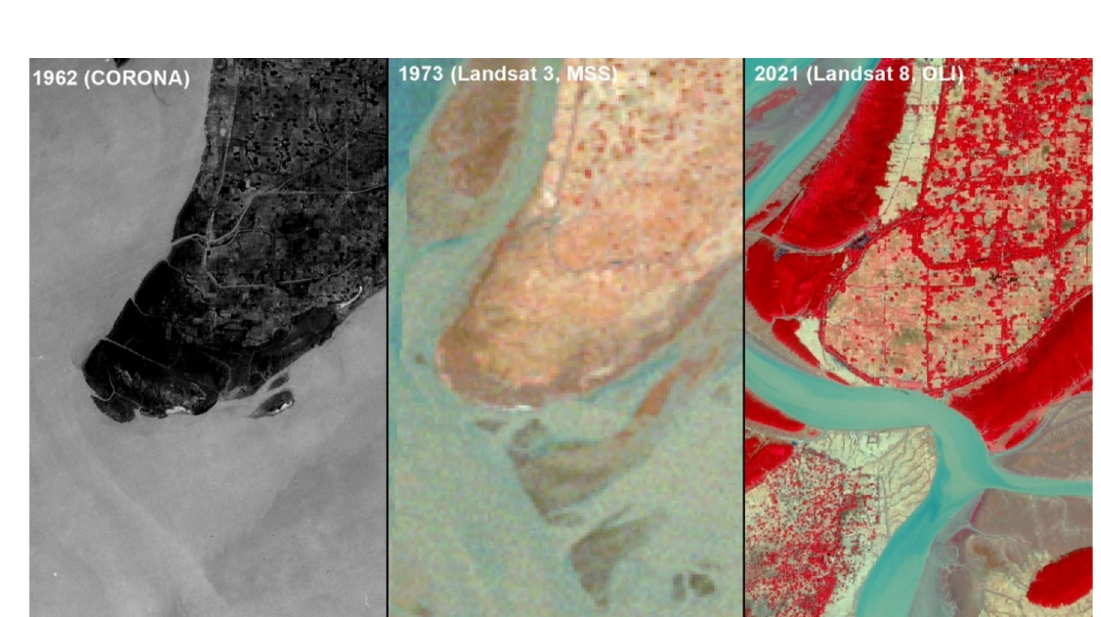
Fig. 2 Processed CORONA satellite imagery and Landsat satellite